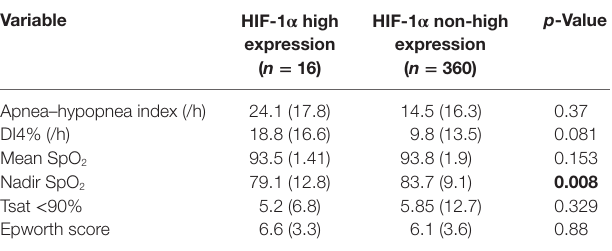
Bold fond indicates p < 0.05. TaBle 6 | Comparisons between the groups with high and low expression of hypoxia inducible factor (HIF)-1 α in relation to sleep-disordered breathing variables and intermittent/continuous hypoxia